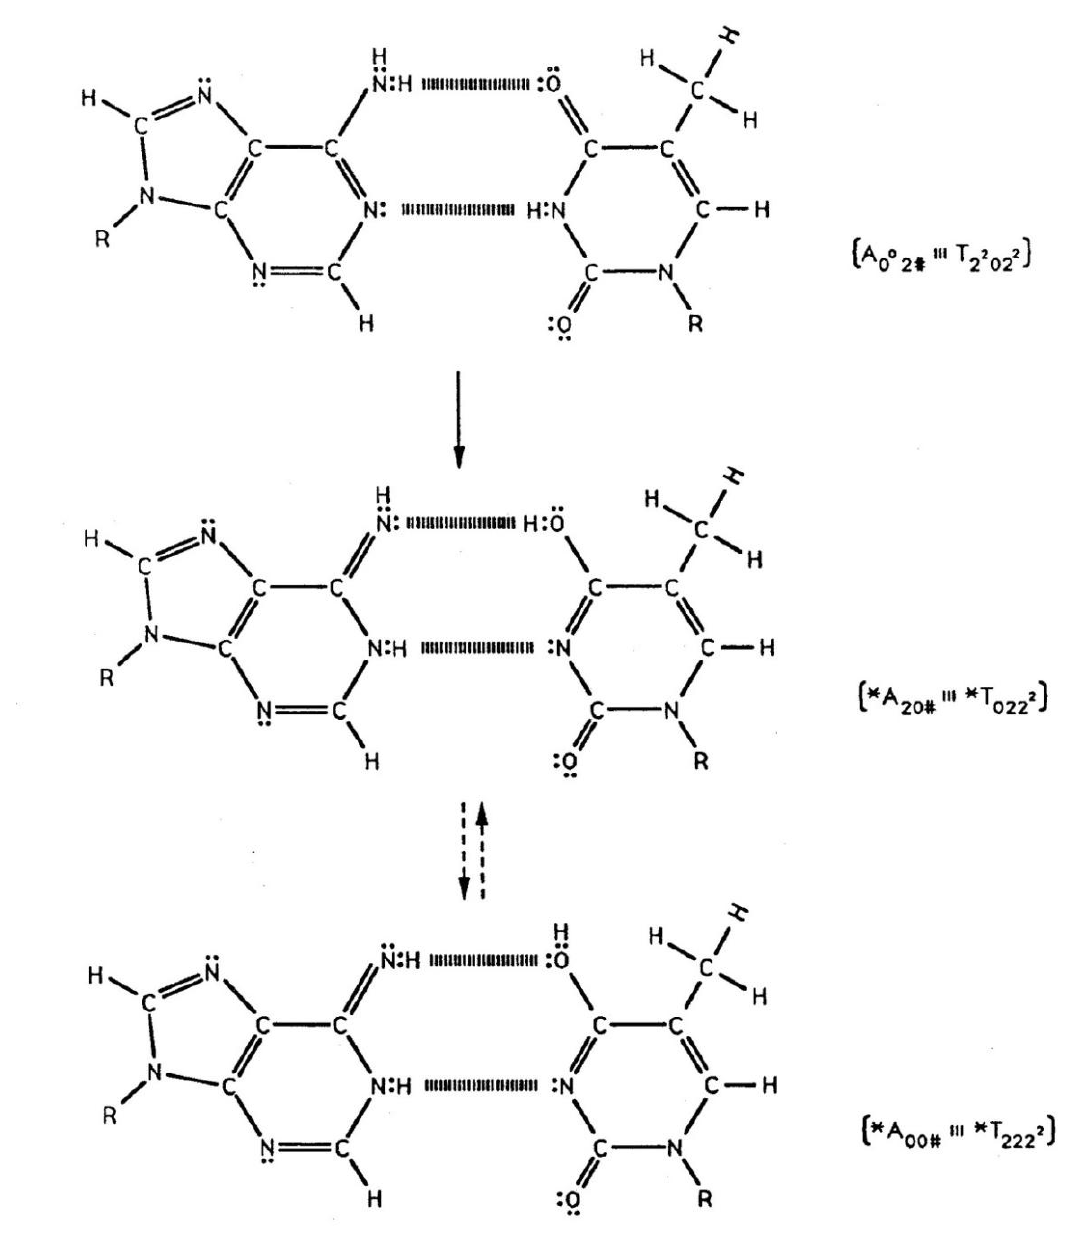
Figure 3 . Metastable and coherent A-T